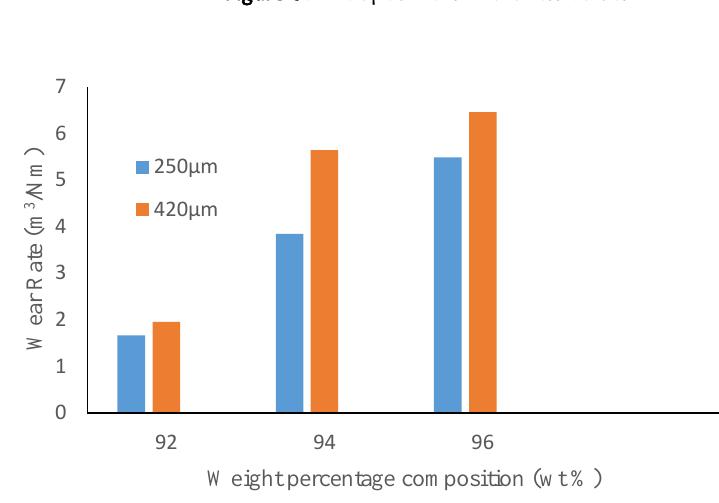
Figure 6 : The Specimens’ Hardness values